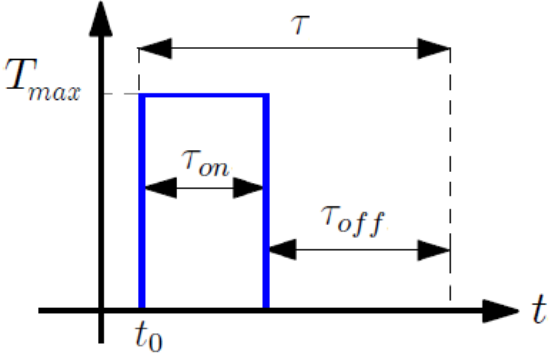
Figure 3. Thrust provided by the i th thruster switched on at time t 0 .